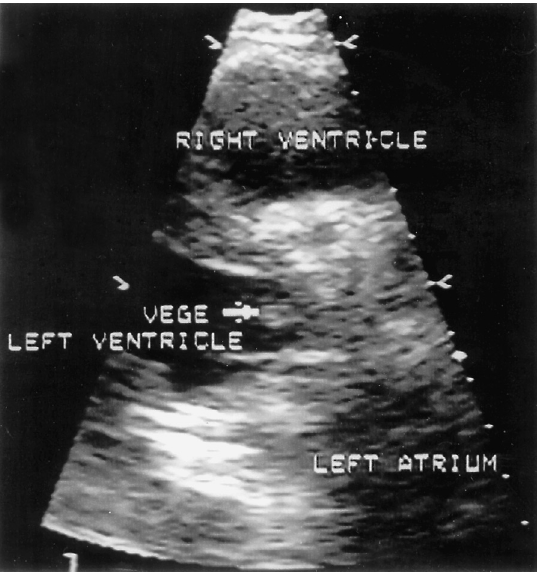
Figure 1 Transthoracic